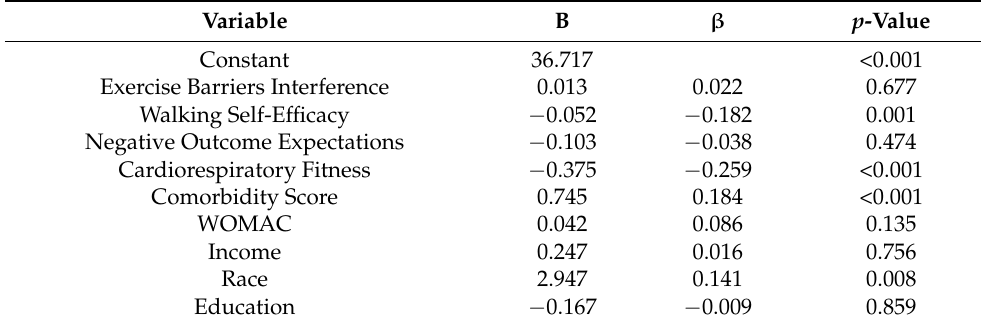
Table 5. Multiple variable linear regression analyses using BMI as the dependent